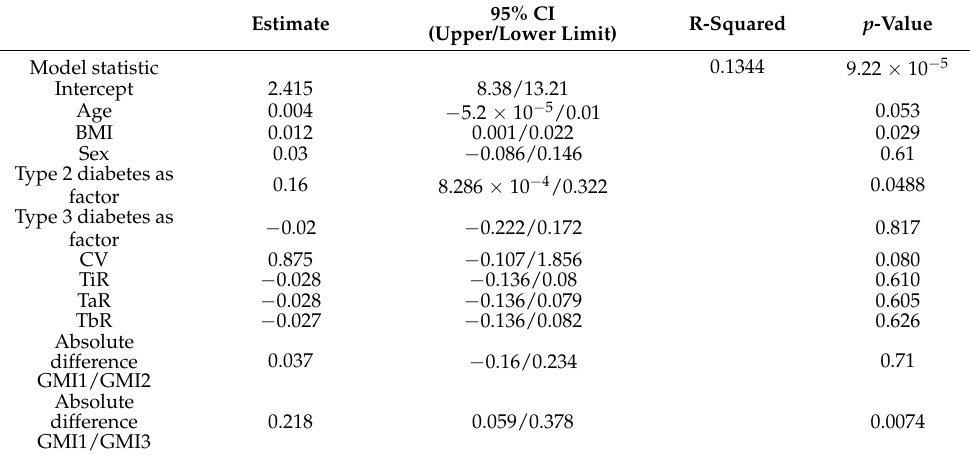
Table 4. Linear regression analysis (CV: coefficient of variation; TiR: time in range; TaR: time above range; TbR: time below range).